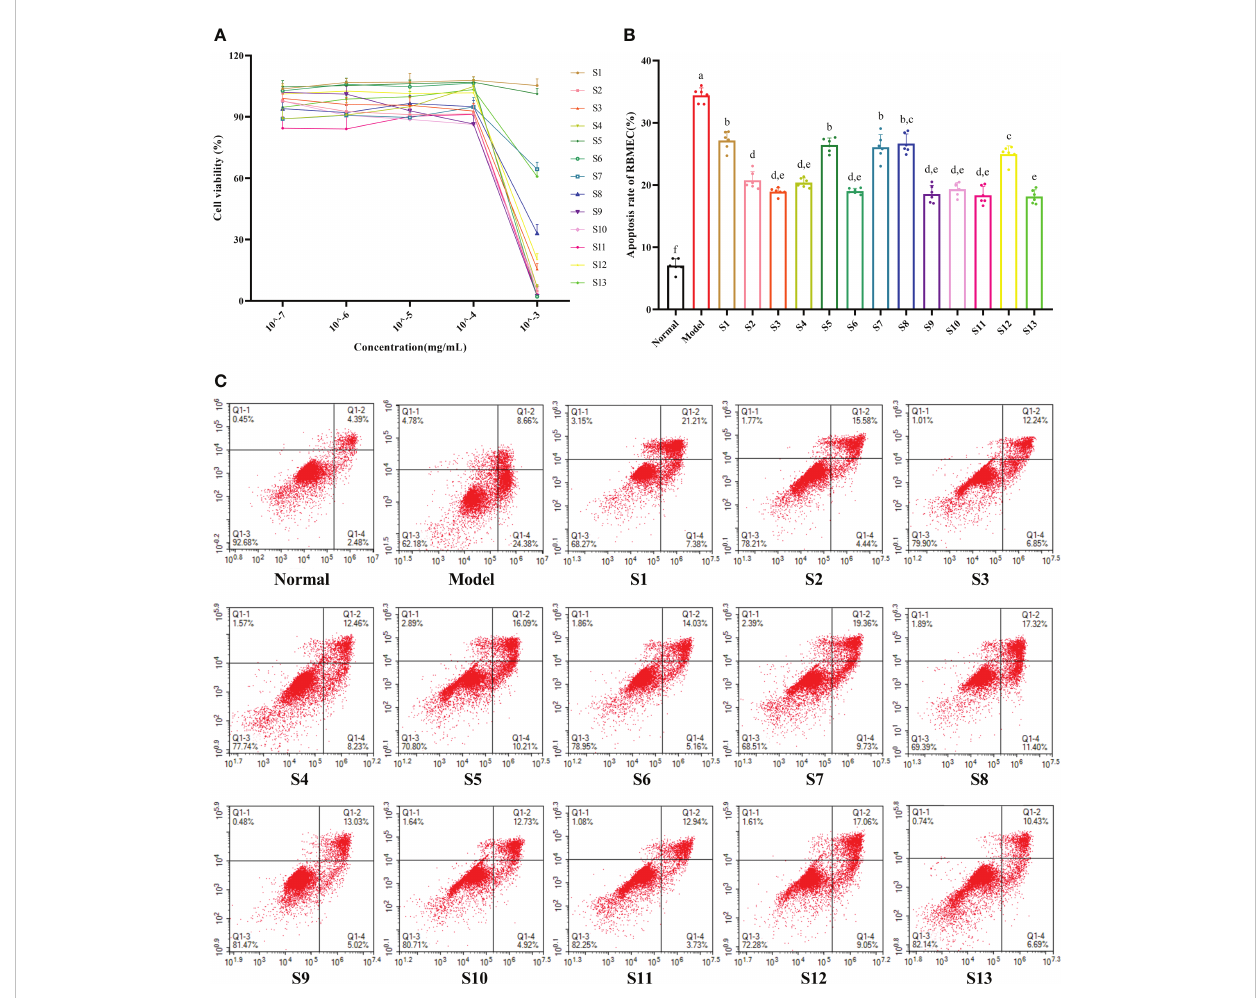
FIGURE 2 Mulberry branch can reduce the apoptosis of rat brain microvascular endothelial cells (RBMECs) in hyperglycemia and hyperlipidemia. S1, Mulberry leaf; S2, Heilongjiang; S3, Liaoning; S4, Hebei; S5, Shanxi; S6, Henan; S7, Jiangsu; S8, Anhui; S9, Zhejiang; S10, Sichuan; S11, Yunnan; S12, Guangxi; S13, Guangdong. (A) , CCK-8 assay to determine the effect of different concentrations mulberry branch extracts on the viability of cells; (B) , Quantitative analysis of the apoptosis rates of RBMECs treated with different mulberry branch extracts for 24 h; (C) , annexin-V/propidium iodide (PI) double staining followed by cytometry analysis was performed to evaluate the cell apoptosis of RBMEC treatment with different mulberry branch extracts for 24 h. The same letter in the two groups of data indicates no signi fi cant difference. Different letters in the two groups of data indicate a signi fi cant difference ( p <